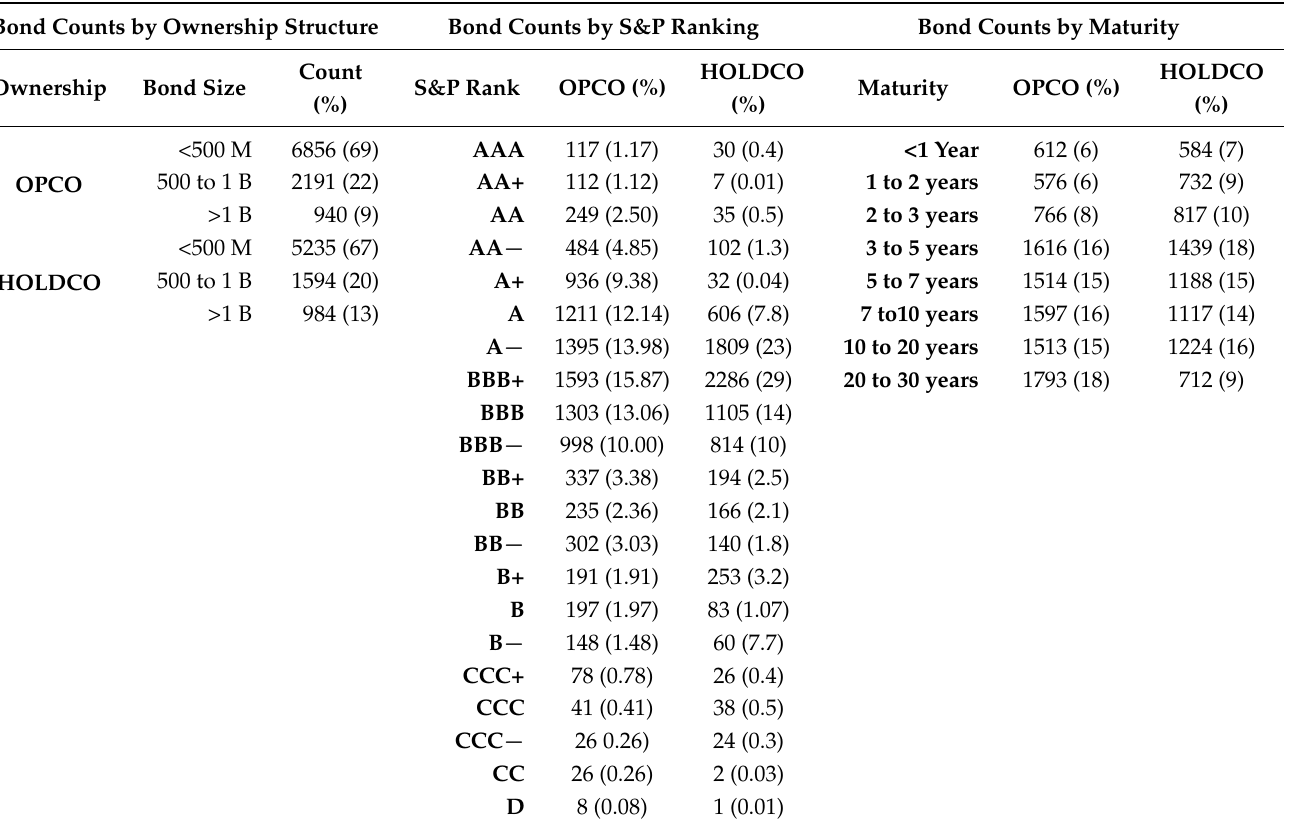
Table 2. The table shows bond counts, using issue size, standard and poor ranking, and maturity for operating and holding companies (source: Bloomberg, accessed on 26 September